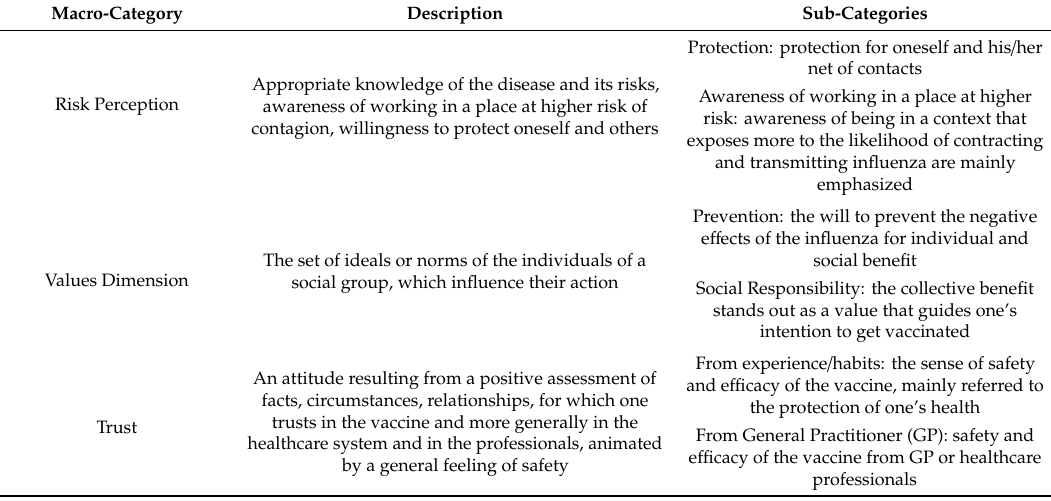
Table 1. Macro-categories and subcategories of reasons to get